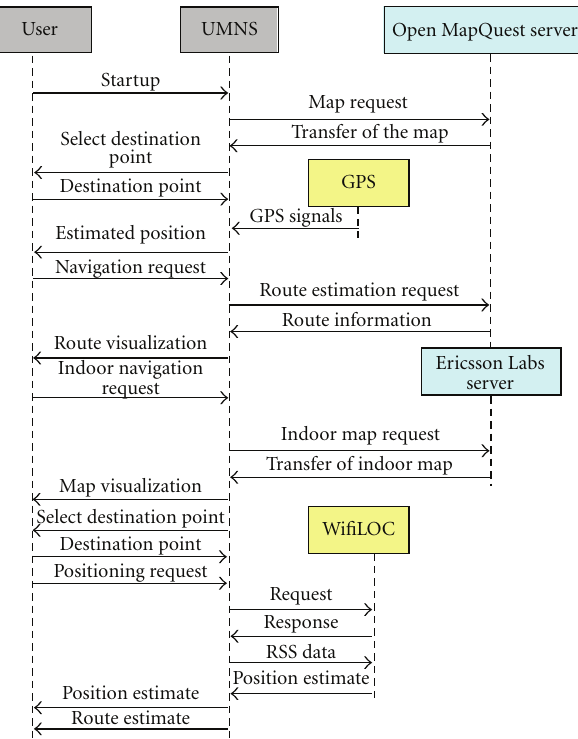
Figure 4: Sequence diagram of the communication in the proposed